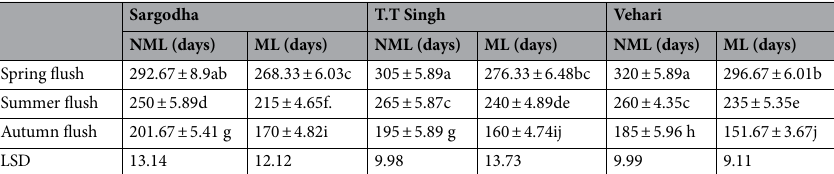
Table 13. Leaf age of non-mined and mined leaves. Results were reported in means (± SD). Means sharing dissimilar letters are significantly differed according to LSD test ( P ≤ 0.05) for both non-mined leaves (NML) and mined leaves